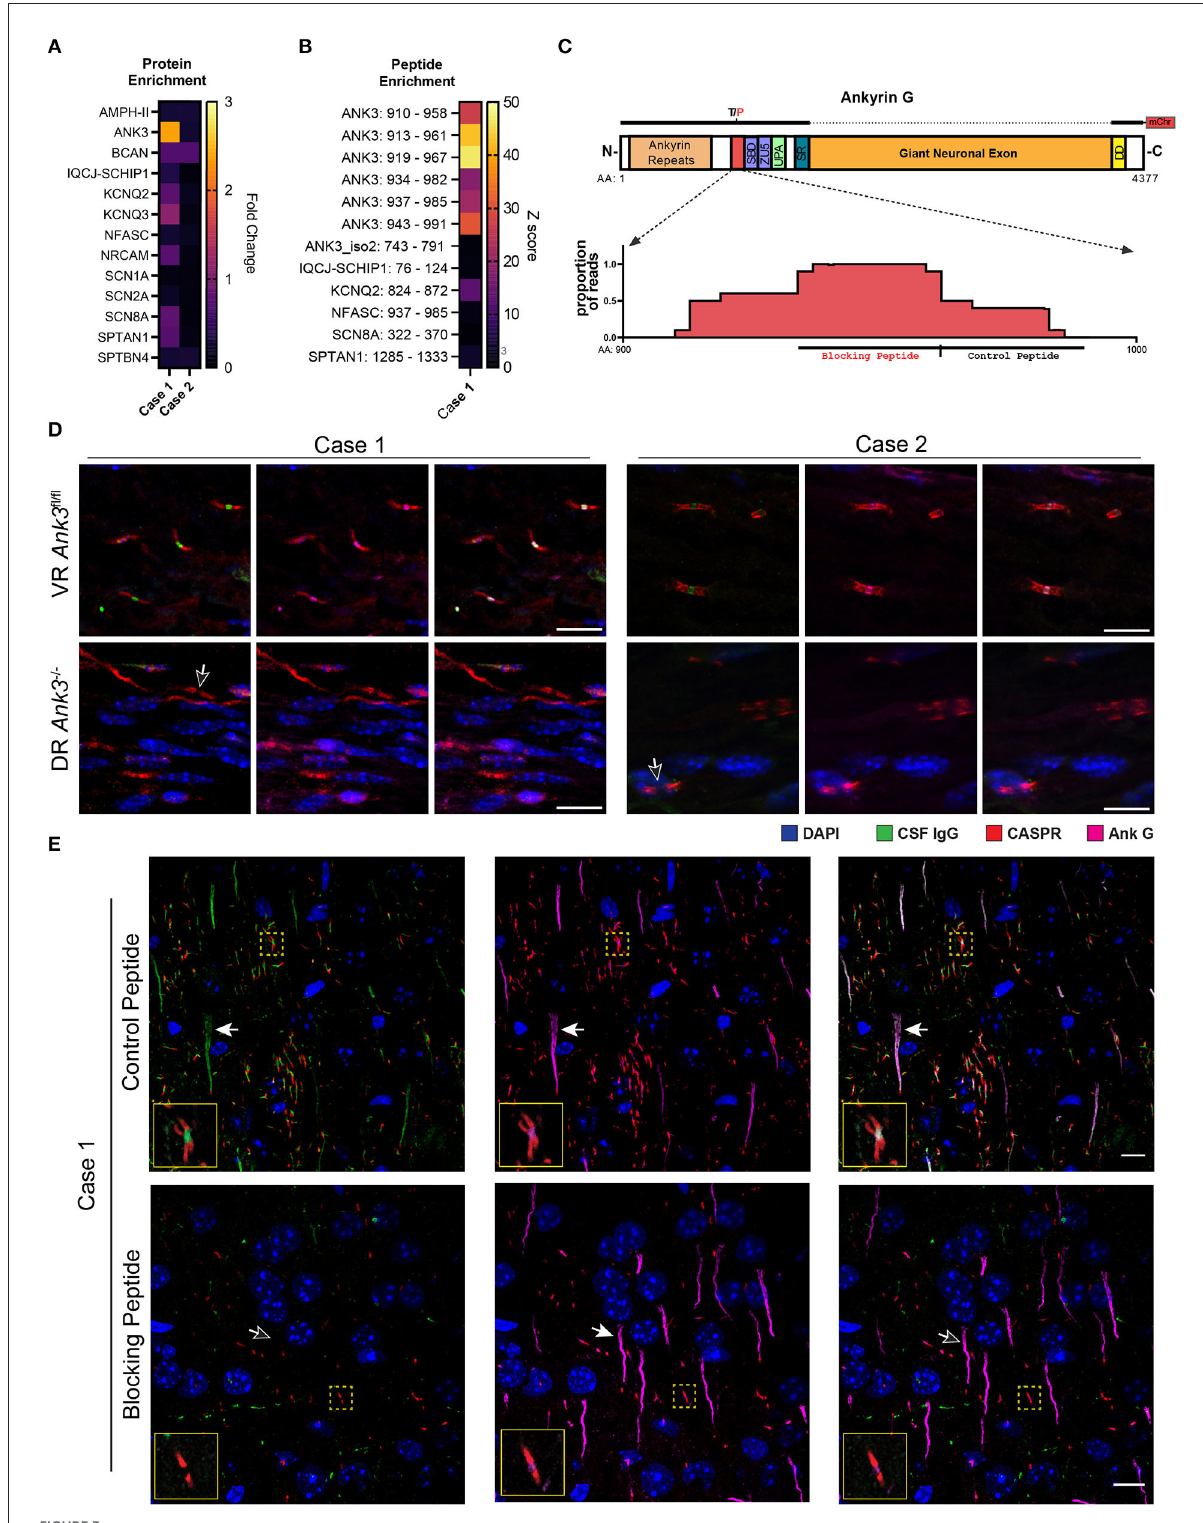
FIGURE3 Validation of AnkG autoantibodies in the CSF of cases 1 and 2. (A) A heatmap of the fold change of PhIP-Seq AIS and NoR protein enrichments for cases 1 and 2 CSF relative to control PhIP-Seq runs ( N = 4,216, comprised of beads only and healthy control CSF and serum). (B) Heatmap